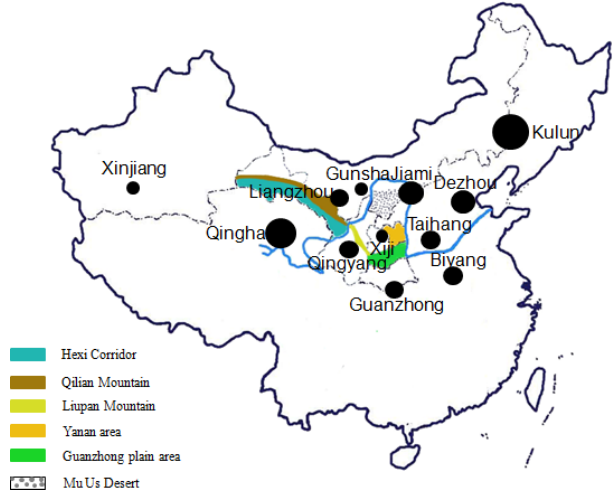
Figure 1. Geographical distribution of 12 Chinese donkey breeds.